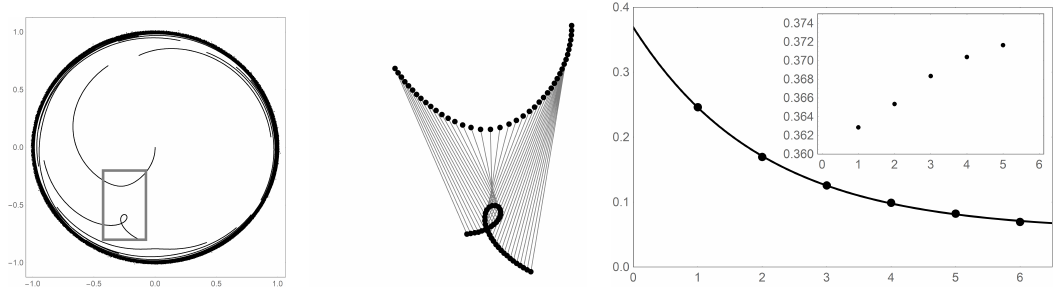
Figure 13. The path of the primary and secondary fixed points as θ increases (left). The middle panel is a blow up of the boxed area of the left graph . The gray tie-lines show the distance between this primary fixed point and this secondary fixed point for a given θ value. The minimum distance decreases with k and seen in the right graph of Figure 13 (abscissa: k, ordinate: distance). Interestingly the θ value that gives the minimum θ min , is a very weak function of k , as shown in the inset plot (abscissa: k , ordinate: θ min ).